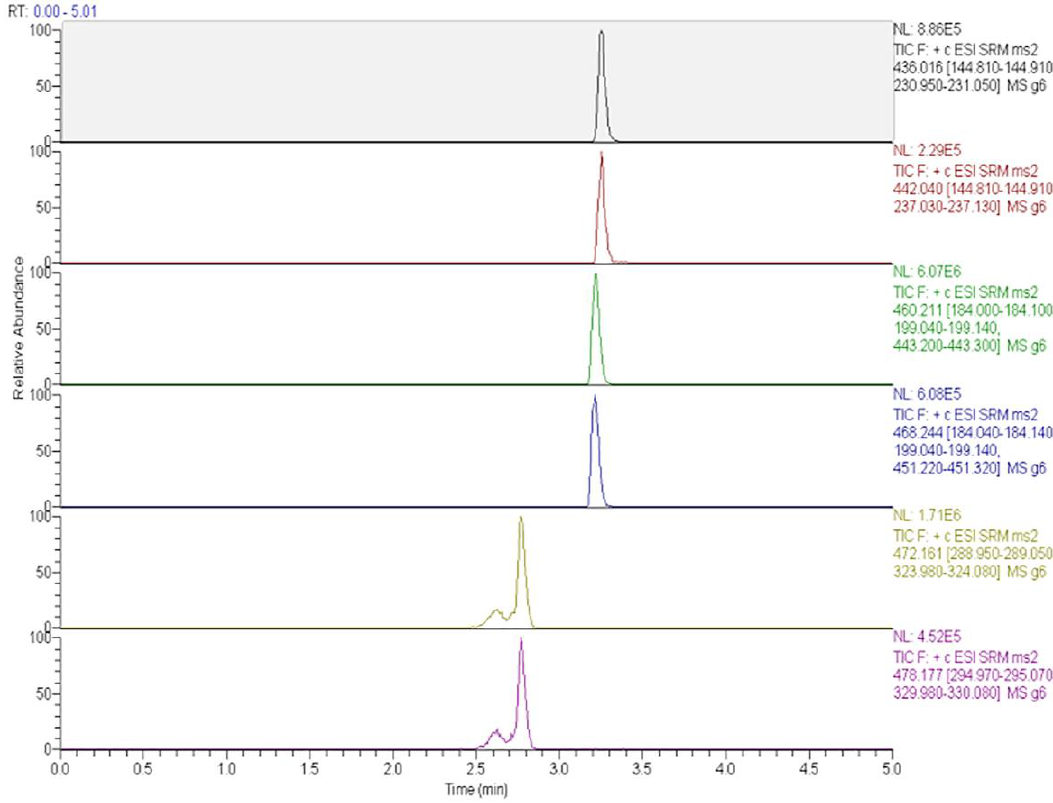
Figure 13. Representative chromatogram with retention times of dabigatran, 13 C 6 -dabigatran, rivaroxaban, 13 C 6 -rivaroxaban, apixaban, and 13 C, 2 H 7 apixaban [148].